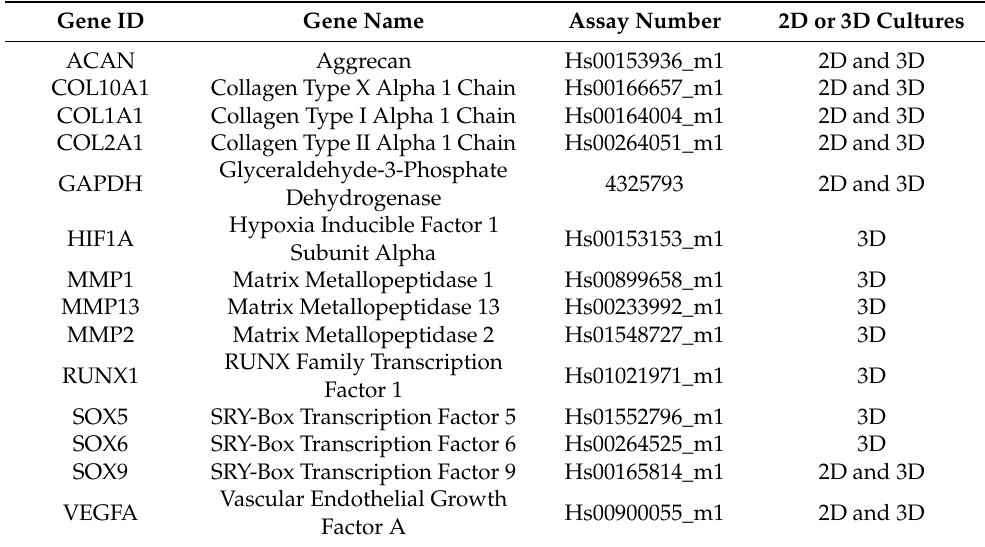
Table 1. Genes IDs and corresponding assay numbers of transcripts analyzed by real-time RT-PCR.